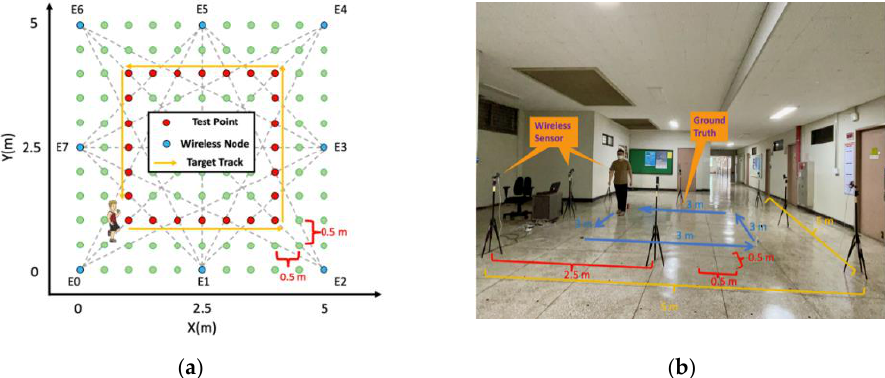
Figure 6. ( a ) Experimental setup. ( b ) Photograph of the experiment setup with the target traversing the predefined path.